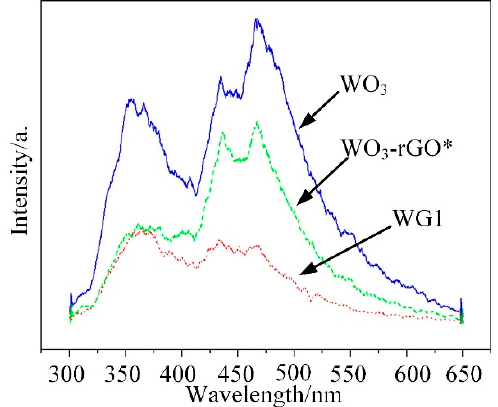
Figure 9. Photoluminescence (PL) emission spectra for pure WO 3 and WG1 nanocomposite. WO 3 -rGO*: the mechanical mixture of WO 3 and rGO (1 wt % GO).